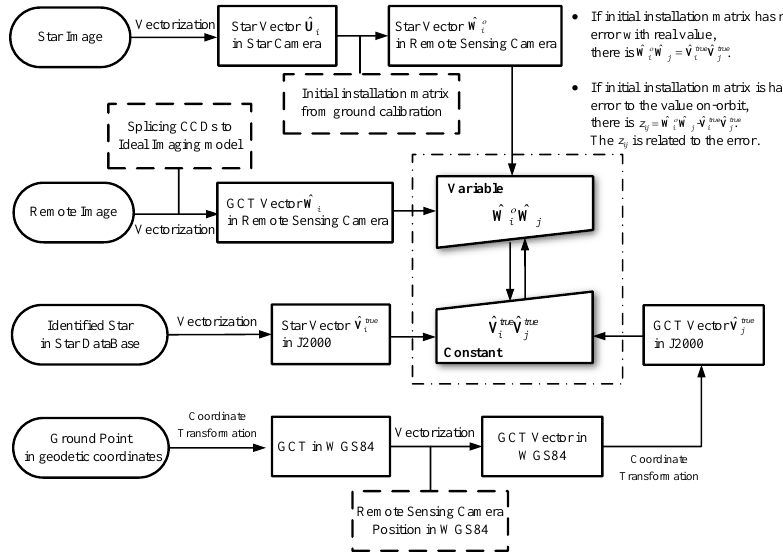
Figure 1. Method Flow Chart.